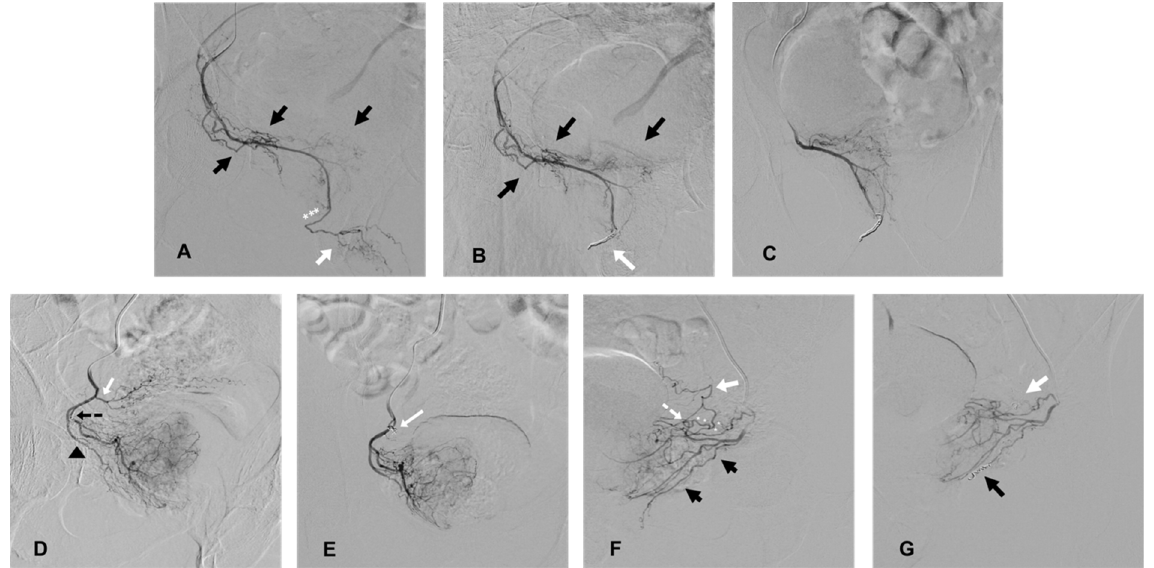
Figure 1. Cases of coil protection of extra-prostatic supplies during PAE and prior to microparticle delivery for safe embolization. ( A – C ) present a case of coil protection of a pattern B prostatic artery (PA). ( A ): selective angiography of the right PA on an ipsilateral oblique view, originating from a right accessory internal pudendal artery (APA). Penile arteries are visible at the end of the APA (white arrow) and distally to the prostatic arterial branches (black arrows); the penile bed should be protected from microparticle non-target prostatic embolization (the elective location of occlusion is marked with white asterisks). ( B ): repeat angiography on ipsilateral oblique view, prior to microparticle delivery, and after a 2 and 3 mm diameter detachable microcoil insertion (white arrow). Penile supply is occluded (penile arteries are no longer opacified) and prostatic vessels are still patent (black arrows). ( C ): repeat angiography on anteroposterior (AP) view prior to prostatic embolization for confirmation of a full uptake of the right hemi prostate. Penile supply is still occluded. ( D , E ) present a case of occlusion of an accessory inferior vesical artery (AIVA). ( D ): selective angiography of the right PA on ipsilateral oblique view. The tip of the microcatheter is inserted in the medial branch of the PA (marked by a black, dotted arrow) and the lateral prostatic branch is marked by a black arrow head. Early reflux is observed in an ipsilateral AIVA (white arrow) originating from the PA, confirming the risk of non-target embolization. ( E ): repeat angiography on AP view prior to PAE and after the insertion of a 2 mm detachable coil in the AIVA (white arrow). The vesical supply is no longer visible and there is a full uptake of the right hemi prostate. ( F , G ) present a case of occlusion of rectal